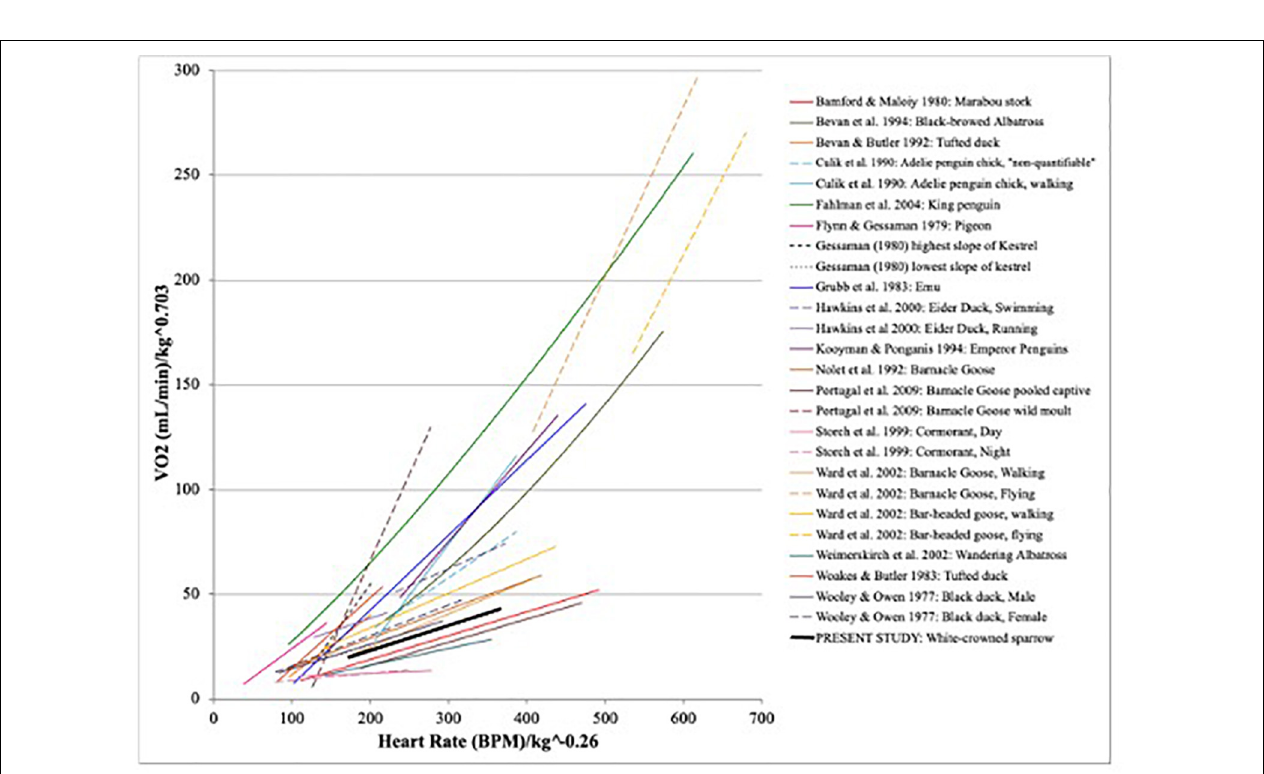
FIGURE 2 | Previously reported relationships between heart rate and oxygen consumption for birds, with the relationship derived herein overlaid for comparison. Species described are: Leptoptilos crumeniferus (Bamford and Maloiy, 1980), Diomedea melanophrys (Bevan et al., 1994), Aythya Fuligula (Bevan and Butler, 1992), Pygoscelis adeliae (Culik et al., 1990), Aptenodytes patagonicus (Fahlman et al., 2004), Columba livia (Flynn and Gessaman, 1979), Falco sparverius (Gessaman, 1980), Dromiceius novaehollandiae (Grubb et al., 1983), Somateria mollissima (Hawkins et al., 2000), Aptenodytes forsteri (Kooyman and Ponganis, 1994), Branta leucopsis (Nolet et al., 1992), Branta leucopsis (Portugal et al., 2009), Phalacrocorax carbo (Storch et al., 1999), Branta leucopsis and Anser indicus (Ward et al., 2002), Diomedea exulans (Weimerskirch et al., 2002), Aythya fuligula (Woakes and Butler, 1983), and Anas rubripes (Wooley and Owen, 1977).